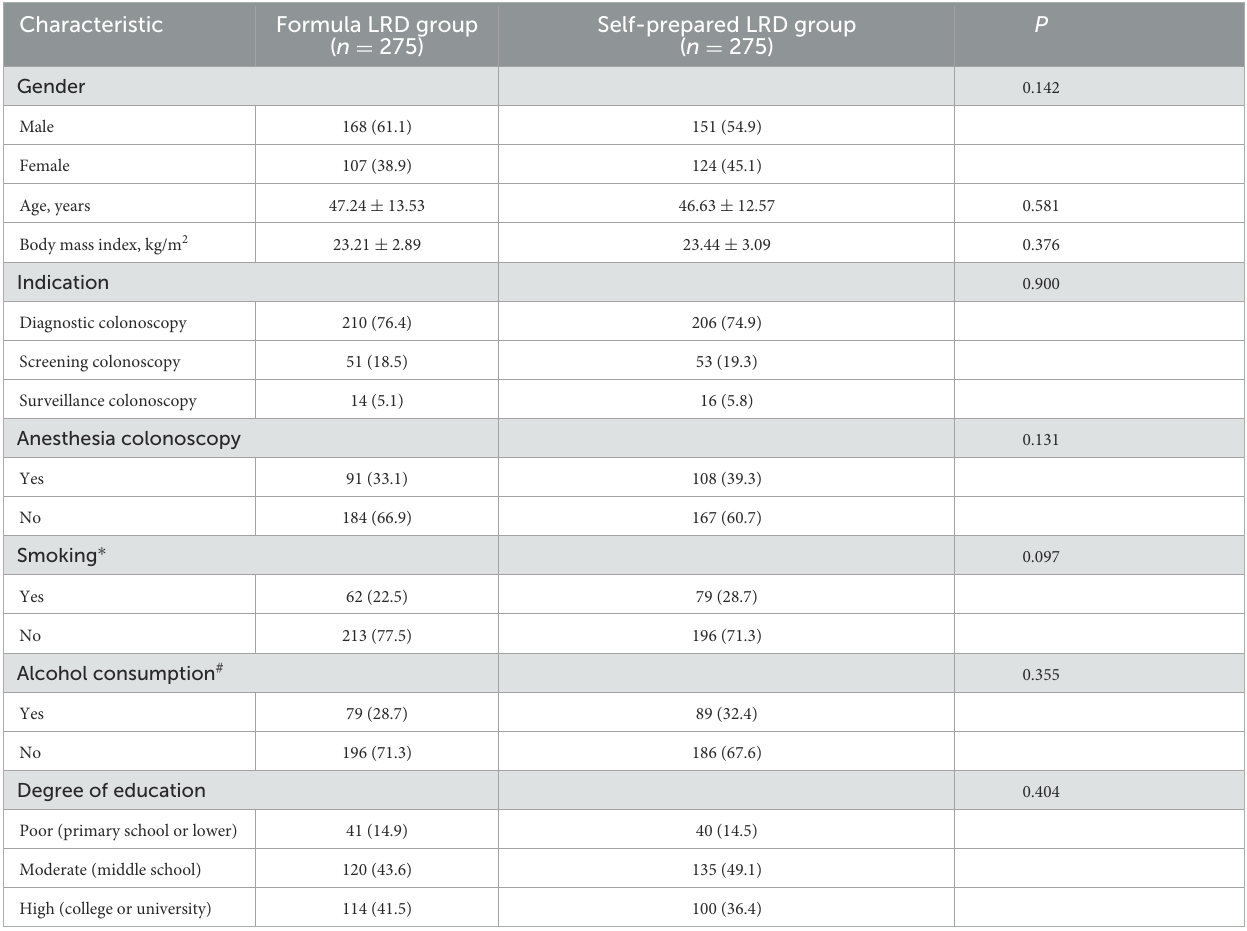
TABLE 1 Demographic and clinical baseline characteristics of